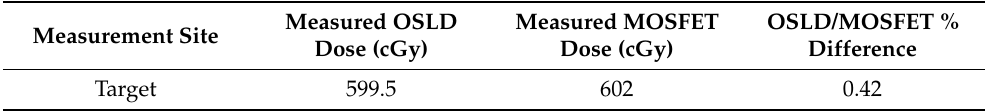
Table 5. Valencia target measurements. Target dose measurement with H3 Valencia. A dose of 600 cGy was delivered to the target.